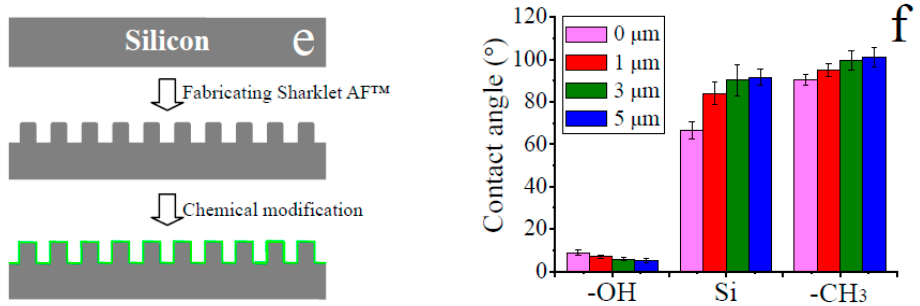
Figure 1. Top-down ( a ) and side-view ( b – d ) at 45° tilt scanning electron microscopy (SEM) images of Sharklet AF™ topography at three different feature heights: ( b ) 1 μ m, ( c ) 3 μ m and ( d ) 5 μ m; ( e ) Schematic illustration of the fabrication procedure of the hierarchical structure; and ( f ) Water contact angle on solid surfaces with different hierarchical structures.